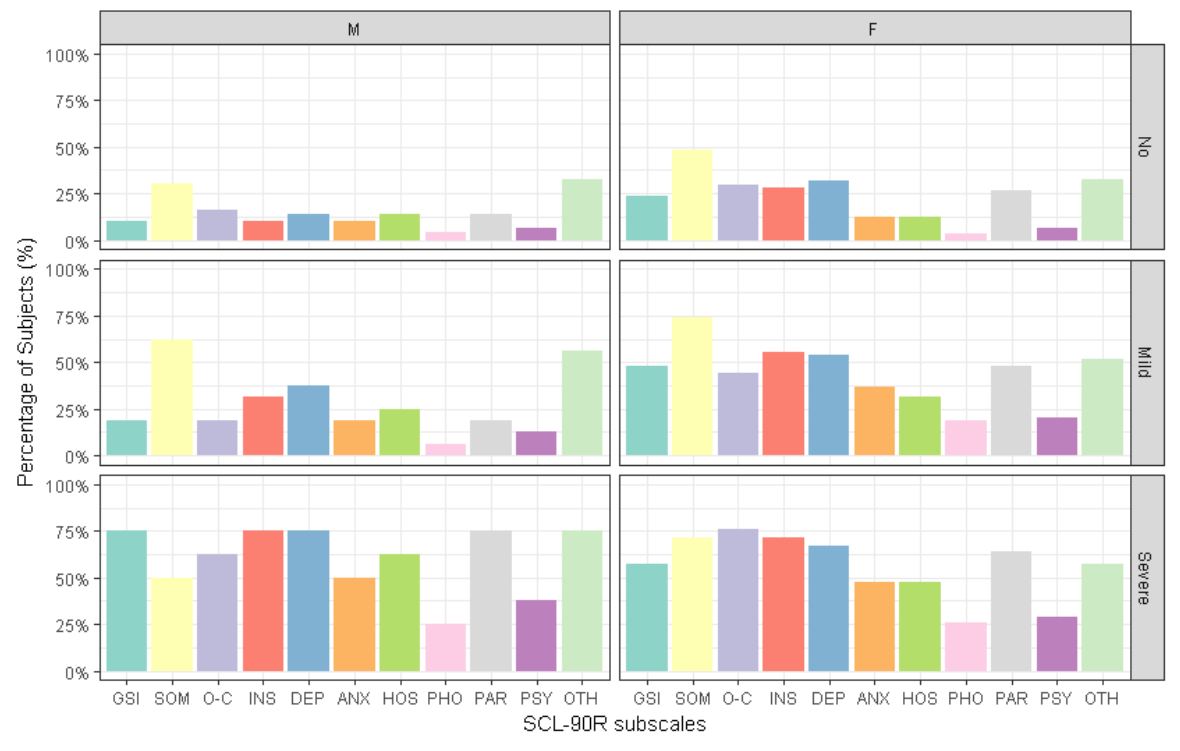
Figure 3. The percentage of subjects with scores that were above the SCL-90-R general population cut-offs, according to binge eating disorder (BED) severity and gender: GSI, Global Severity Index; SOM, somatization; O-C, obsessive–compulsive; INS, interpersonal sensibility; DEP, depression; ANX, anxiety; HOS, hostility; PHO, phobic anxiety; PAR, paranoidal ideation; PSY, psychoticism; OTH, other symptoms (additional items).